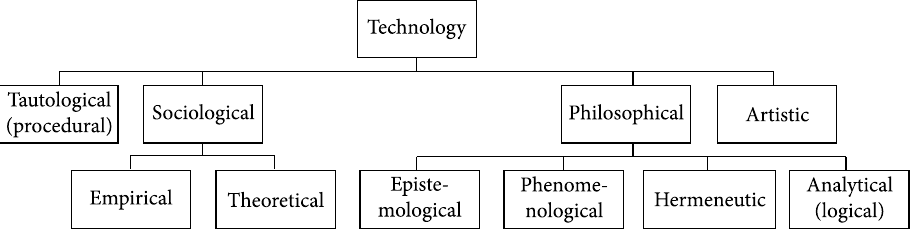
Fig. 2. Interpretations of